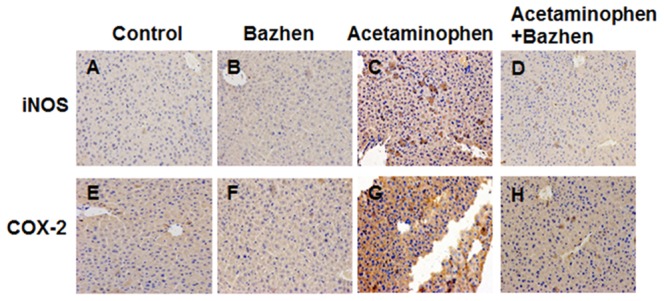
Effects of Bazhen decoction on acetaminophen-induced immunohistochemical stain of iNOS and COX-2 expression in liver tissue.Typical images were shown for iNOS expression in (A) control, (B) Bazhen, (C) acetaminophen and (D) acetaminophen + Bazhen group, and COX-2 expression in (E) control, (F) Bazhen, (G) acetaminophen and (H) acetaminophen + Bazhen group. Original magnification 200×.